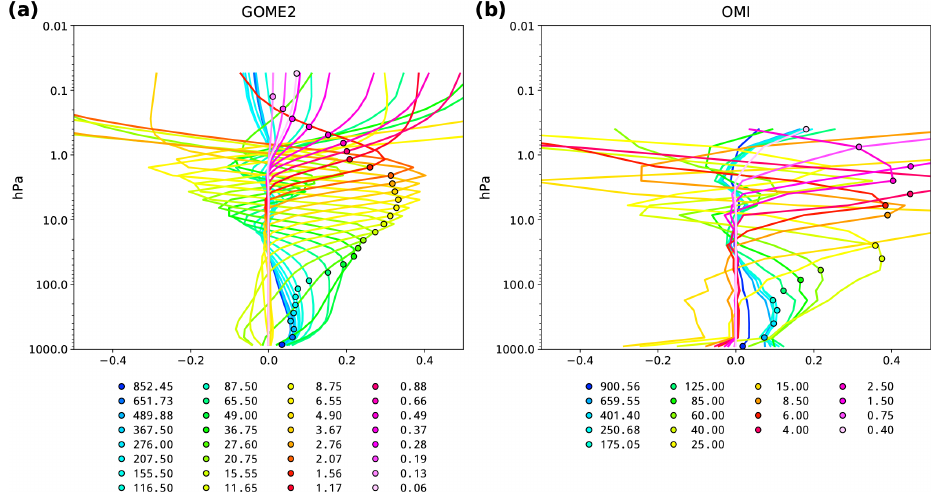
Figure 4. Mean AKs calculated from all assimilated retrievals from GOME-2 (a) and OMI (b) . The markers show the altitude of the retrieval layer, which is listed in hPa in the legend below each plot.